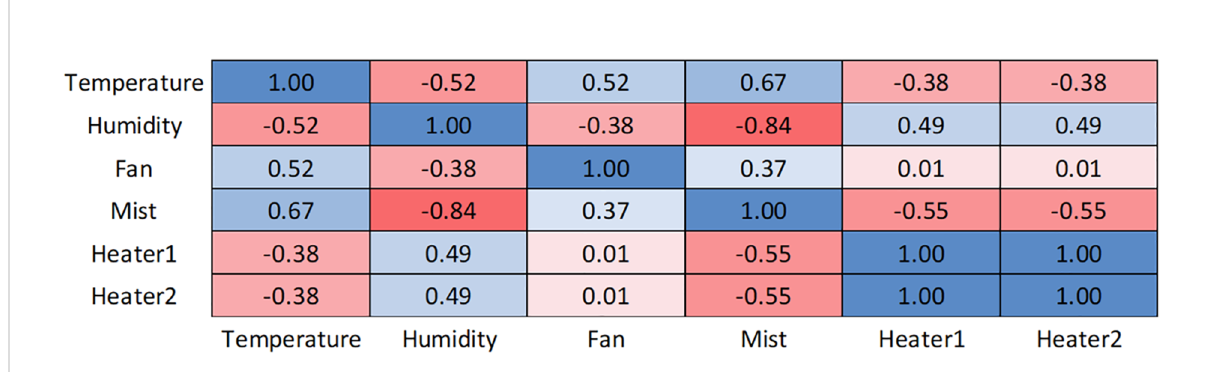
FIGURE 12 Heatmap of correlations between input and output variables based on Pearson ’ s correlation coef fi